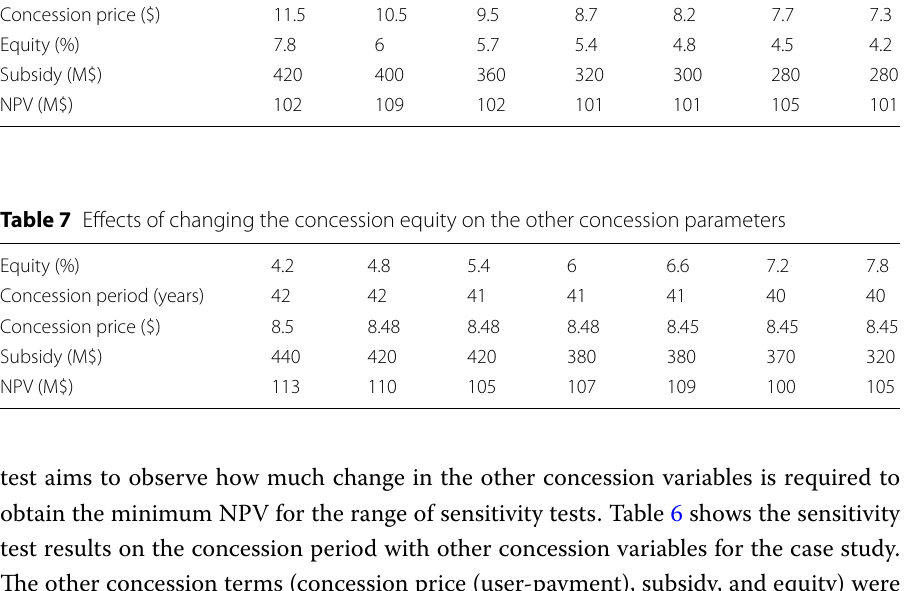
Table 6 Effects of changing the concession period on the other concession parameters Concession period (years)